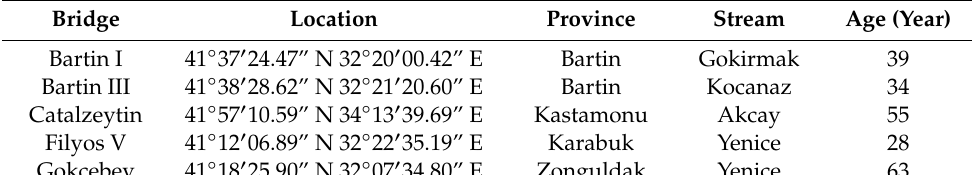
Table 1. River bridges inspected in the pilot area of the study.